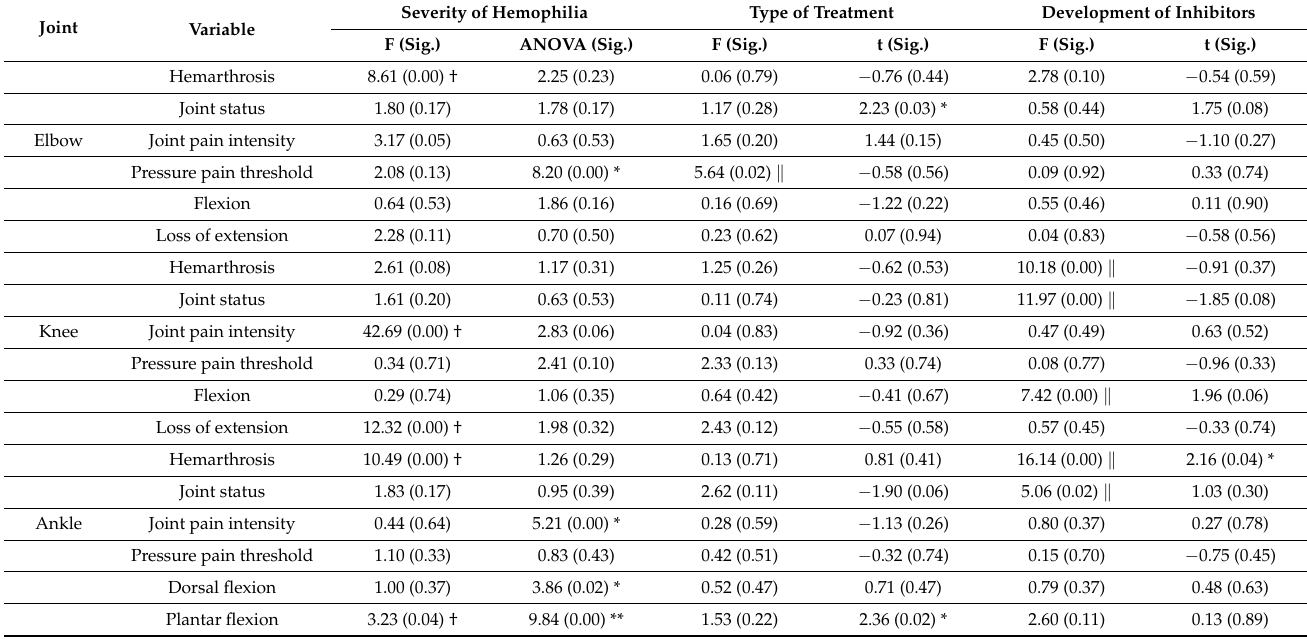
Table 3. Changes according to the degree of hemophilia severity, type of treatment and the development of